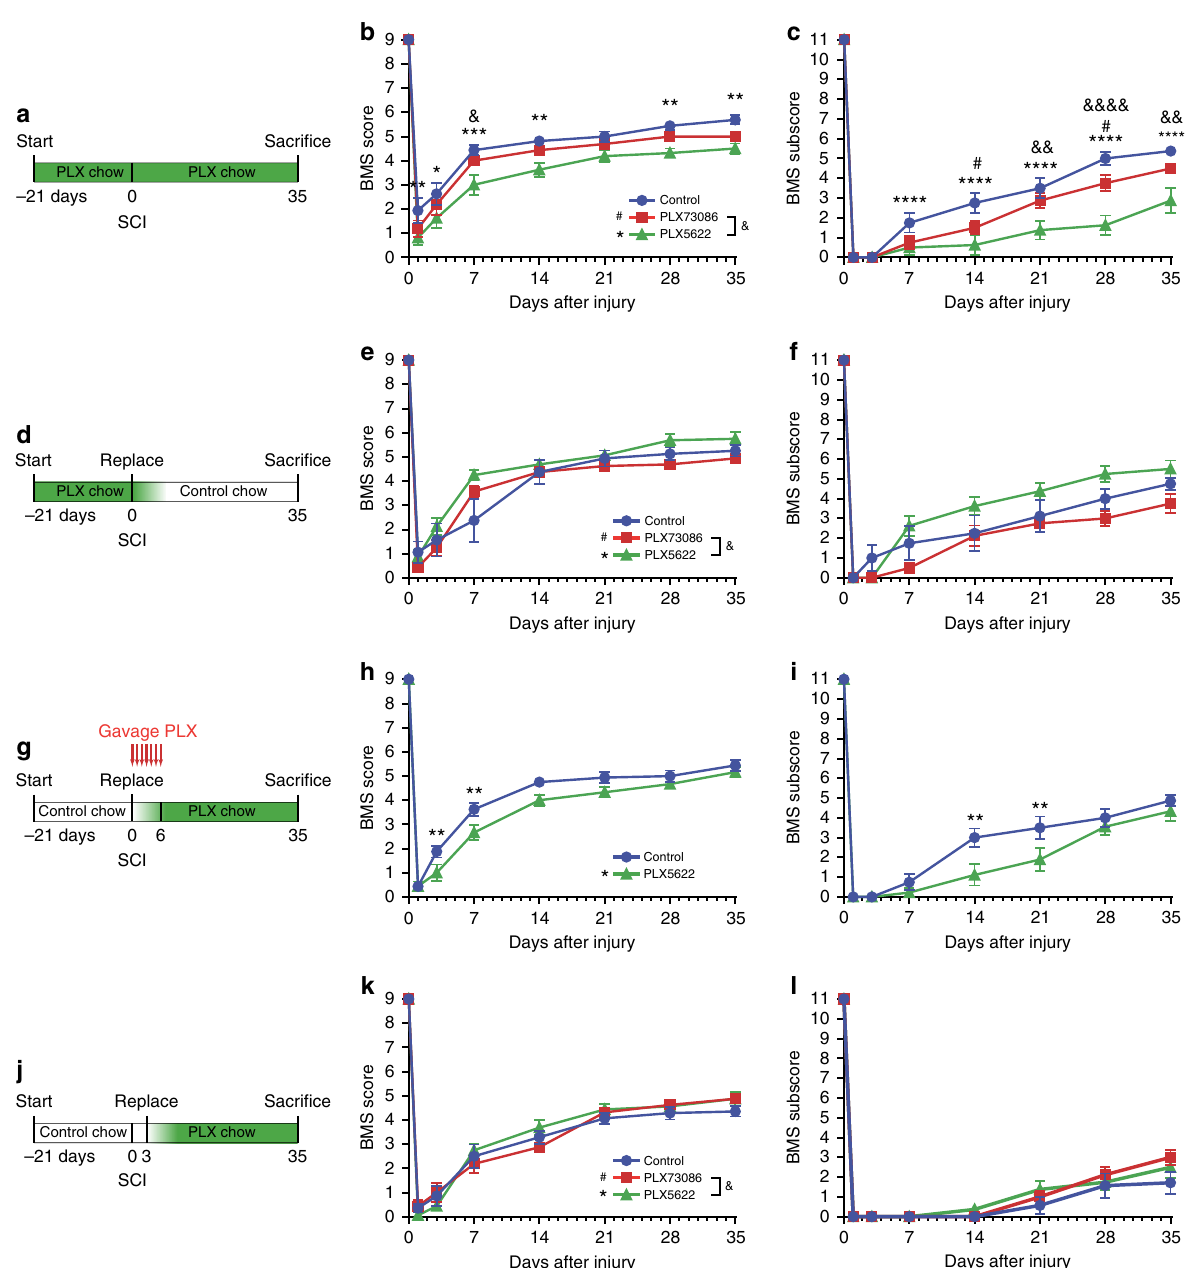
Fig. 3 Microglia play a key role in recovery of locomotor function during the fi rst week post-SCI. a , d , g , j Schematics of experimental design showing the timeline of microglia depletion, spinal cord contusion, behavioral testing using the Basso Mouse Scale (BMS), and sacri fi ce. CSF1R inhibitors and vehicle were administered in the diet or by oral gavage, as indicated. b and c , e and f , h and i , k and l Locomotor function was assessed using the BMS score ( b , e , h , k ) and BMS subscore ( c , f , i , l ) over a 35-day period after SCI ( n = 8 mice per group). Data are expressed as mean ± SEM. * p < 0.05, ** p < 0.01, *** p < 0.001, **** p < 0.0001, PLX5622 versus the control group; # p < 0.05, PLX73086 versus the control group; and & p < 0.05, && p < 0.01, &&&& p < 0.0001, PLX5622 compared to PLX73086. Statistical analysis was performed using a two-way repeated-measures ANOVA followed by a Bonferroni ’ s post hoc